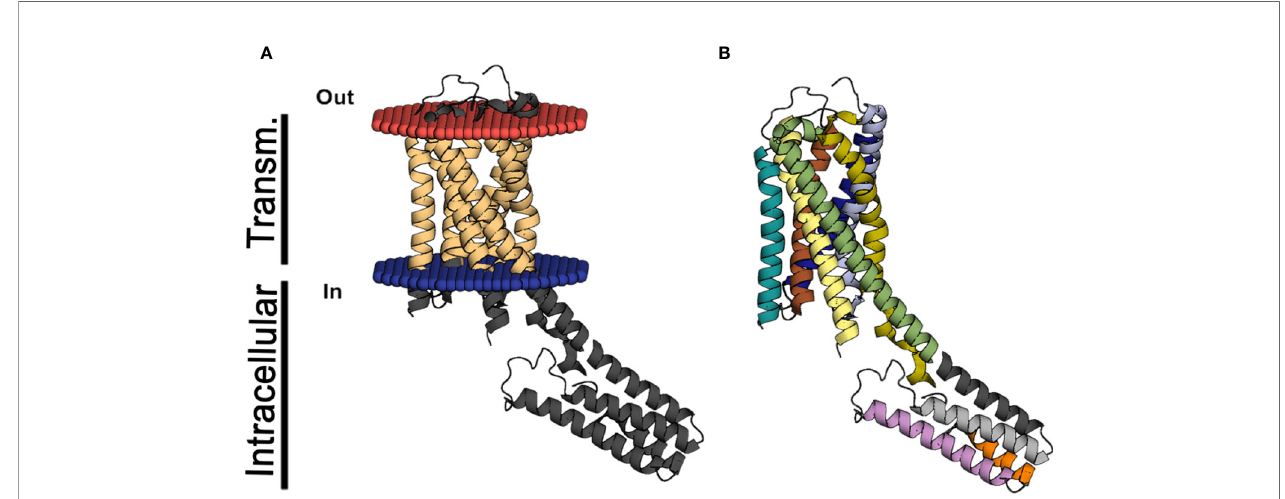
FIGURE 2 | 3D structure of P2Y12. The structure in (A , B) represents the P2Y12 (PDB code 4PXZ) crystal in the lateral view. (A) indicates the helix in light brown represents the transmembrane domain of P2Y12 and (B) exhibits the same segments represented in dark blue, light blue, red, yellow, brown, light brown, and green. The intracellular helices are represented in (A) in dark gray and in (B) , in gray, light gray, orange and purple. The part of the transmembrane domain that extends to the intracellular space is displayed in yellow and